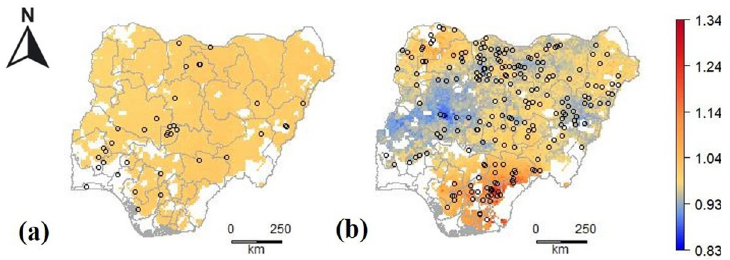
Fig 7. Predicted relative urea price (local price divided by the observed median national price) for areas with crop land in (a) Nigeria using Africa fertilizer data; (b) Nigeria using LSMS